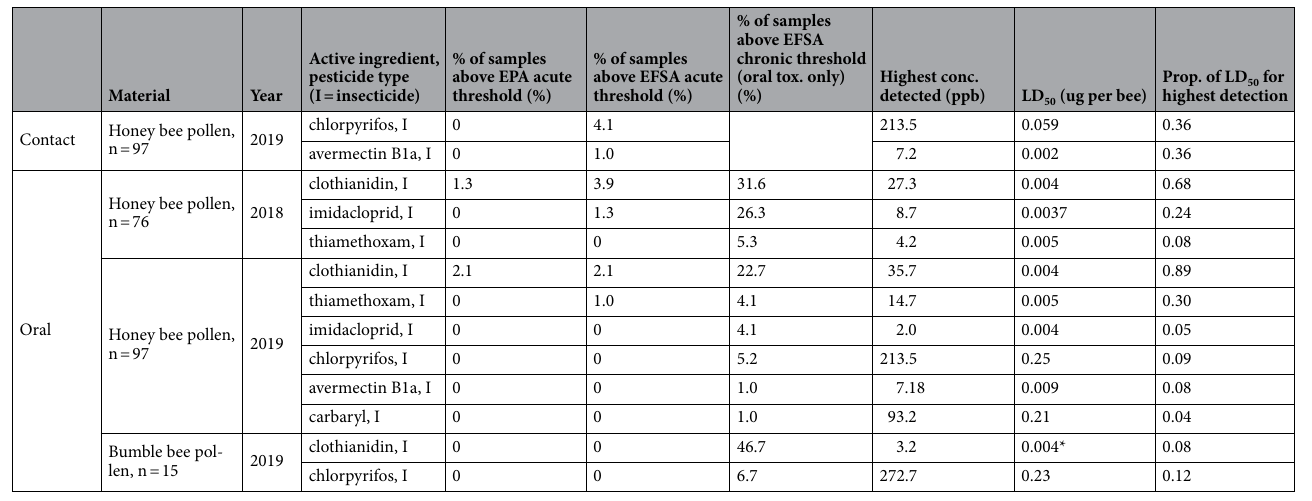
Table 2. Percent of samples with active ingredient detections above the EPA (0.4) and EFSA (0.2) acute risk thresholds. For a chronic risk threshold (oral toxicity only), the EFSA uses 0.03. Both contact and oral LD 50 values were used to calculate risk and are presented separately. N is the number of samples. Sample types without detections above thresholds are excluded. Asterisks (*) marks where honey bee toxicity data was used for bumble bee collected